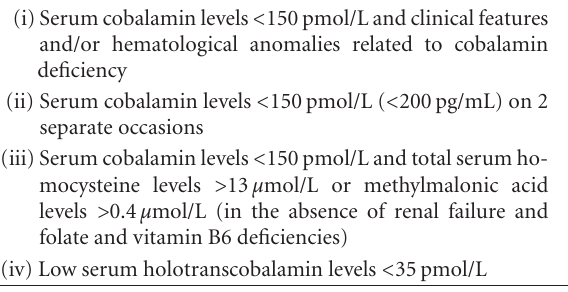
Figure 1: Cellular impact of cobalamin deficiency.